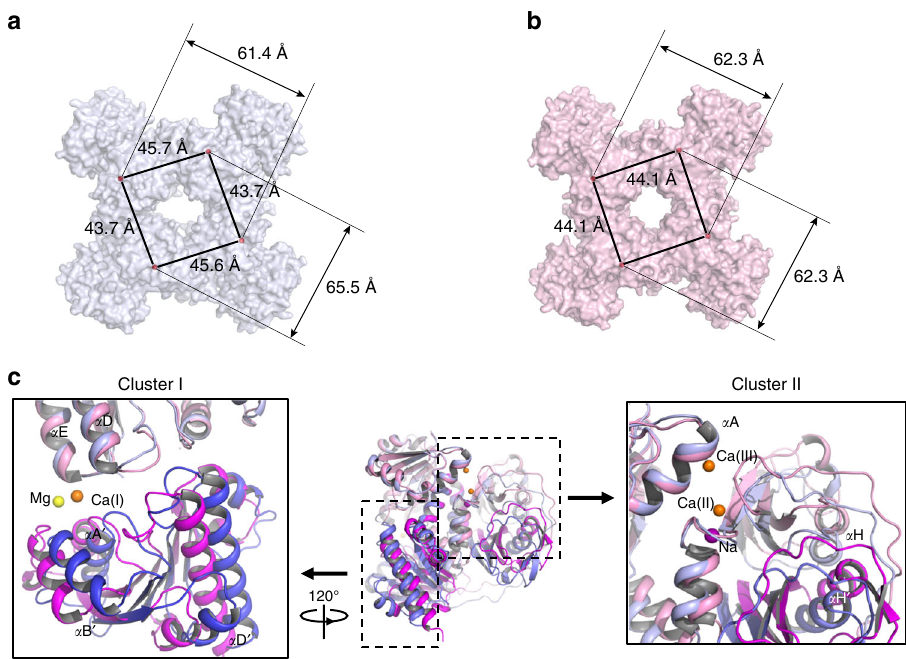
Fig. 6 Crystal structure of the apo LjCASTOR gating ring. a Surface-rendered representation of the apo gating ring, which is no longer fourfold symmetrical. Distances are measured between the C α atoms of Thr 323 s from two neighboring or diagonal subunits. b Surface-rendered representation of the Ca 2 + - bound gating ring. c Single subunit superimposition between Ca 2 + -bound (RCK1 in pink and RCK2 in magenta) and apo (RCK1 in light blue and RCK2 in blue) structures. The RCK1 N-lobes were used in the structural alignment. Insets are zoomed-in view of the structural differences at the cluster I (left) and II sites (right). In each inset, the other subdomains of no interest were removed for visual